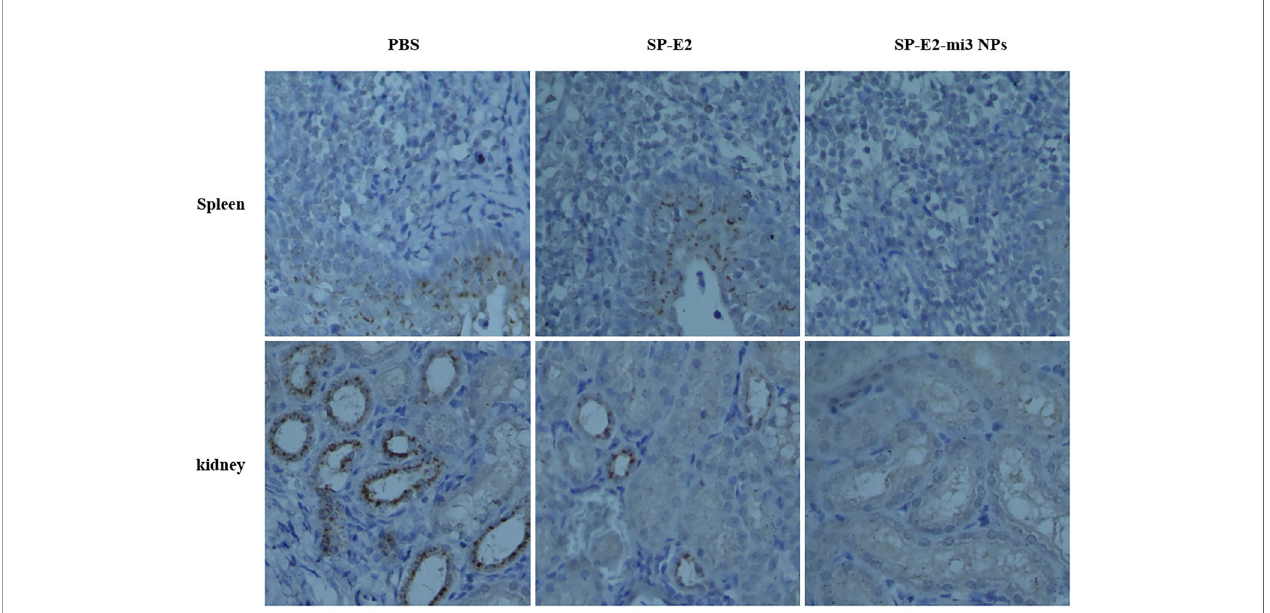
FIGURE 7 | Detection of CSFV antigen in the tissues from SP-E2-mi3 NPs vaccinated piglets by immunohistochemistry assay. Using CSFV polyserum as primary antibody, the brown dots represent CSFV speci fi c